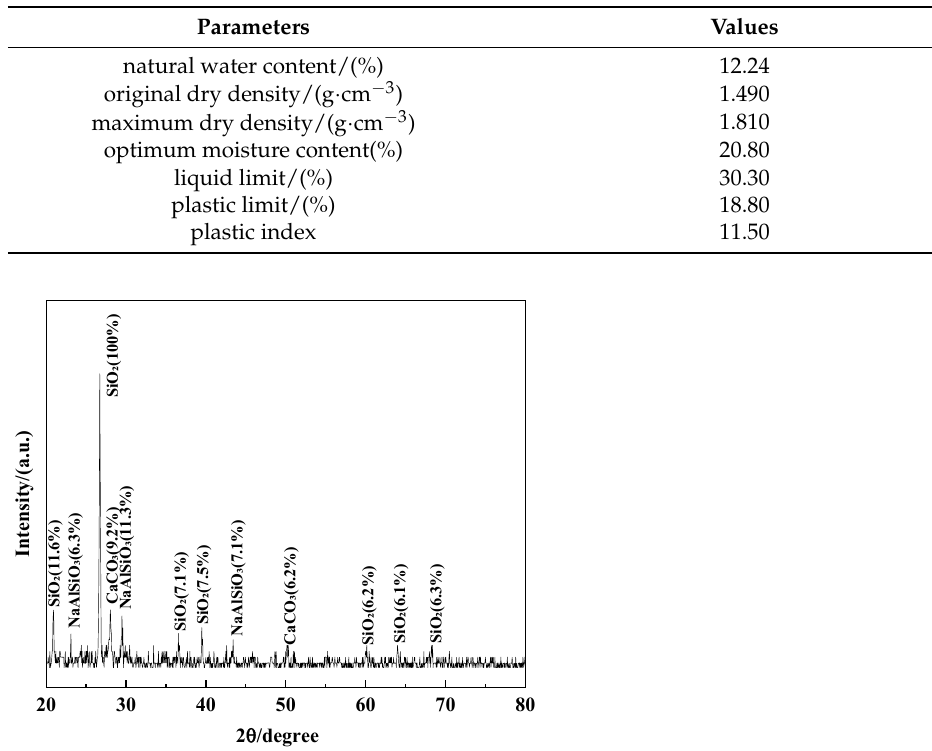
Table 3. Proportion of soil samples with different NaCl content . Water Content/(%)